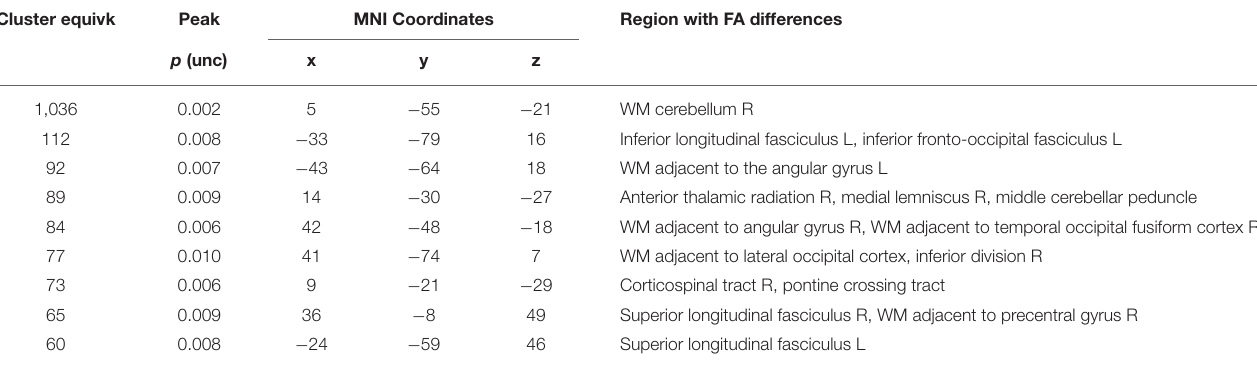
TABLE 7 | Regional brain differences in structural connectivity as measured by FA between HC and bvFTD patients at p < 0.01, corrected for multiple comparisons. Cluster equivk Peak MNI Coordinates Region with FA